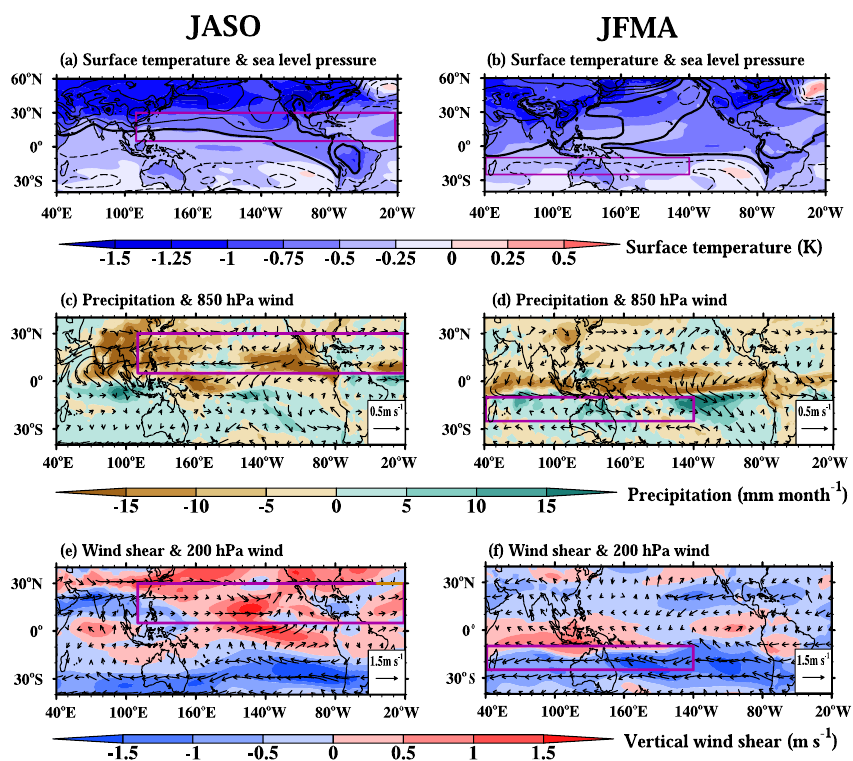
Fig. 3 The impacts of anthropogenic aerosol on tropical cyclone (TC) environmental fi elds. The left and right panels show the changes in the Northern Hemisphere TC season (July-October, JASO) and the Southern Hemisphere TC season (January − April, JFMA) between the modern period (1985 – 2014) and pre-Industrial period (1850 – 1879), respectively. a , b surface temperature (shaded, K) and sea level pressure (contour, Pa). The solid and dashed lines indicate the positive and negative values, respectively, with a contour interval of 20 Pa. The zero lines are bolded. c , d 850 hPa circulation (m s − 1 ) and precipitation (shaded; mm month − 1 ). e , f 200 hPa circulation (m s − 1 ) and vertical wind shear (magnitude of wind difference between 850 hPa and 200 hPa, shading, m s − 1 ). The purple boxes denote the Northern Hemisphere and Southern Hemisphere tropical cyclone formation